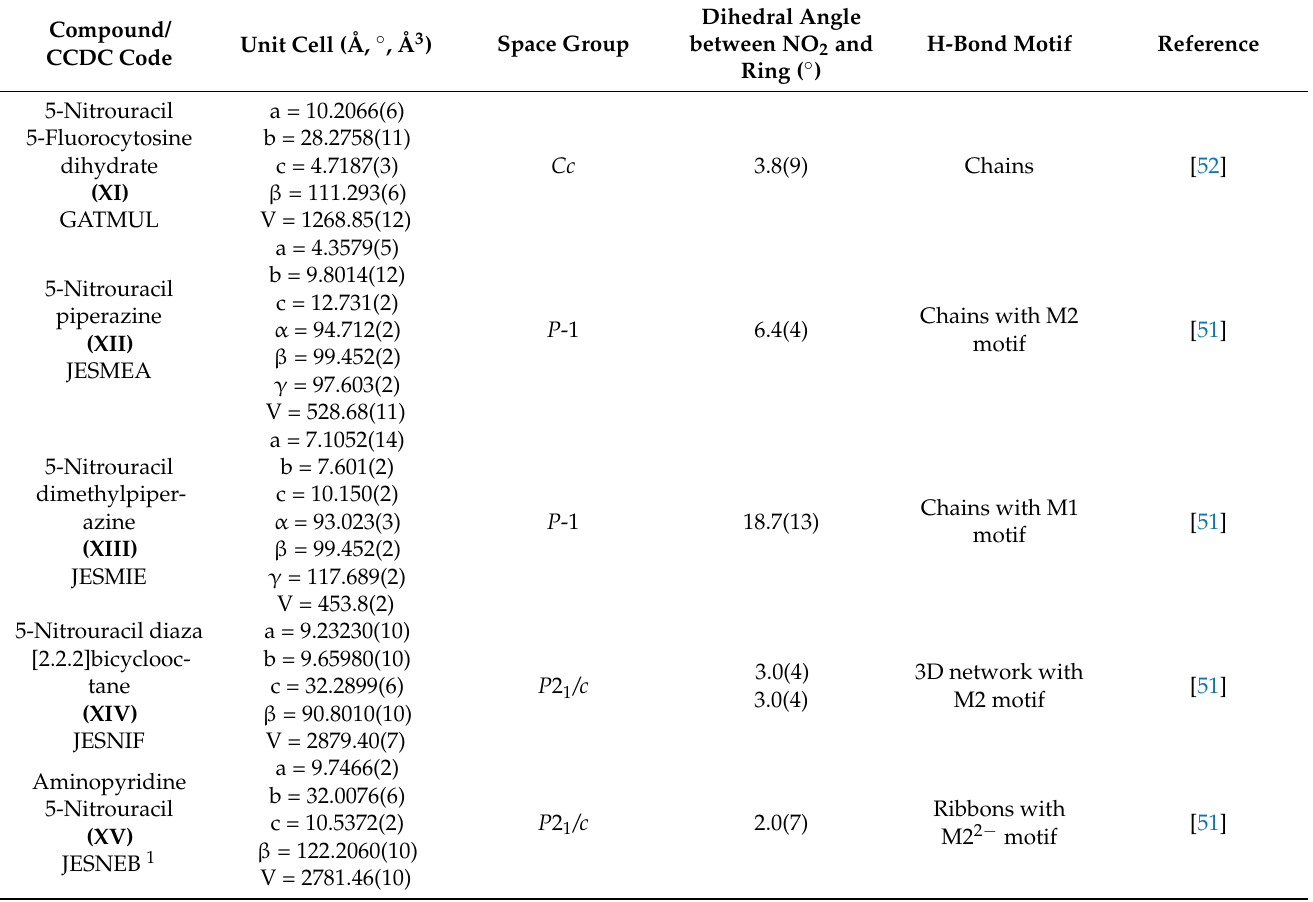
Table 5. Crystallographic data of 5NU